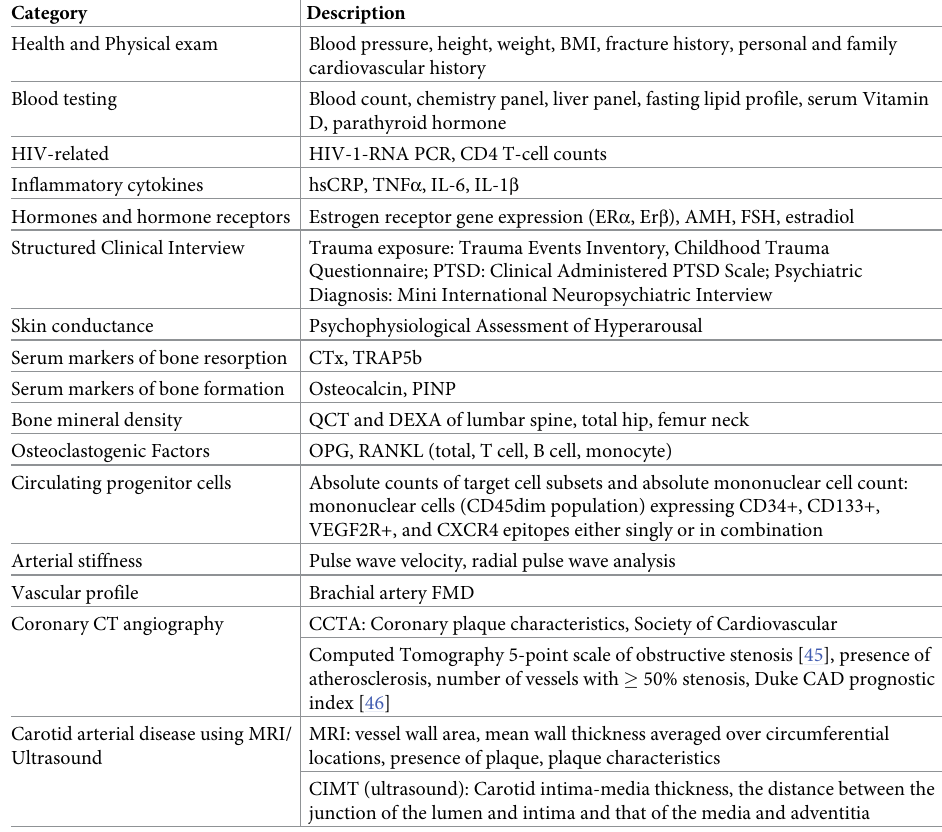
Table 2. Description of information collected in Brain, Bone, Heart (BBH)